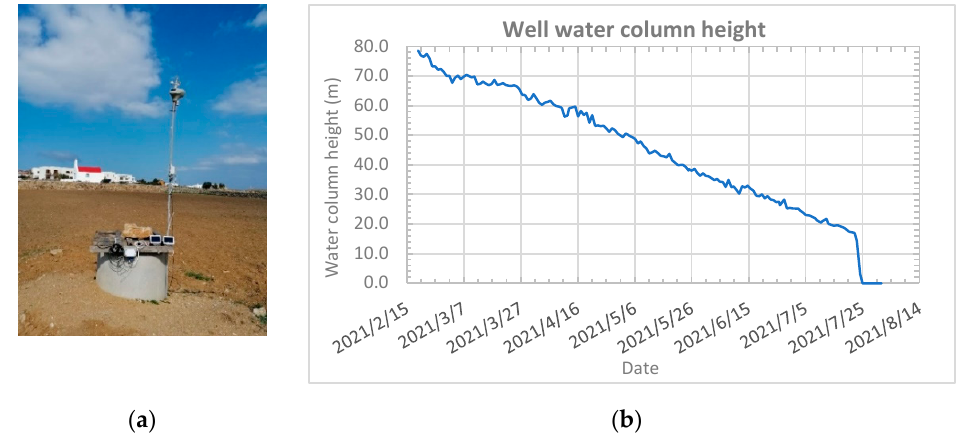
Figure 14. ( a ) Nodes for monitoring the well depth. ( b ) Water depth in the well (depth of the aquifer).